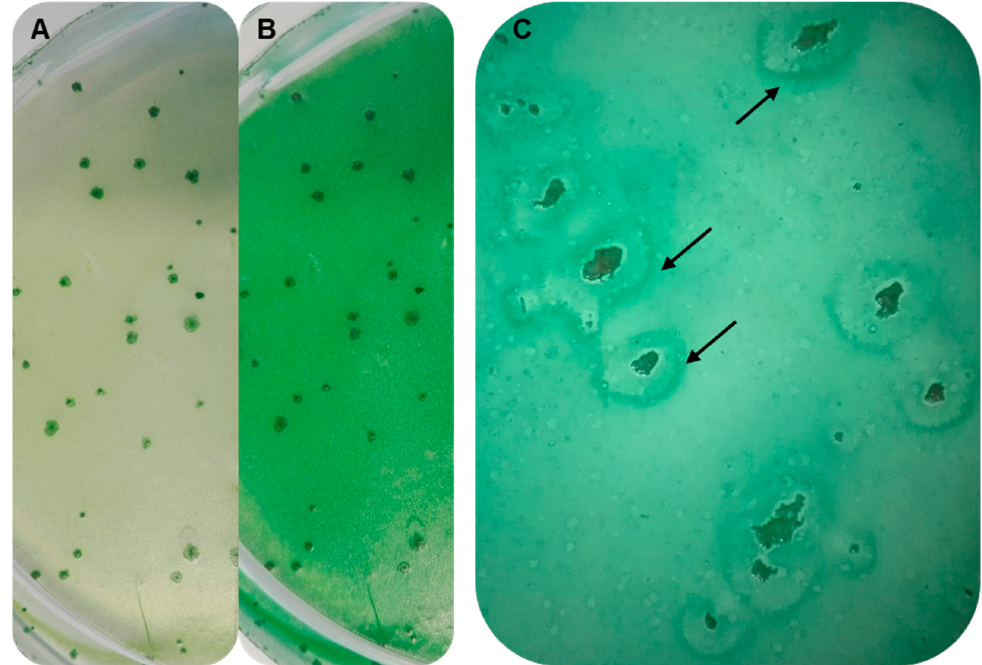
Figure 7. Cultivation of the cyanobacterial strain SAG 88.79 with or without the fungal strain AGSC12 on agar plates. ( A , B ) Spirulina plate flooded by the mixture of SAG 88.79 and AGSC12 cells. The cyanobacterial cells became denser near the fungi within a few days of cultivation ( A ) and retained the advantage over a long cultivation period, too ( B ). ( C ) Sequential flooding of the cells. The SAG 88.79 cell-mass was thicker around the fungal colonies as the black arrows indicate. The cyanobacterial strain SAG 88.79 attained higher cell density in the presence of the fungal strain AGSC12 on plates, as well.